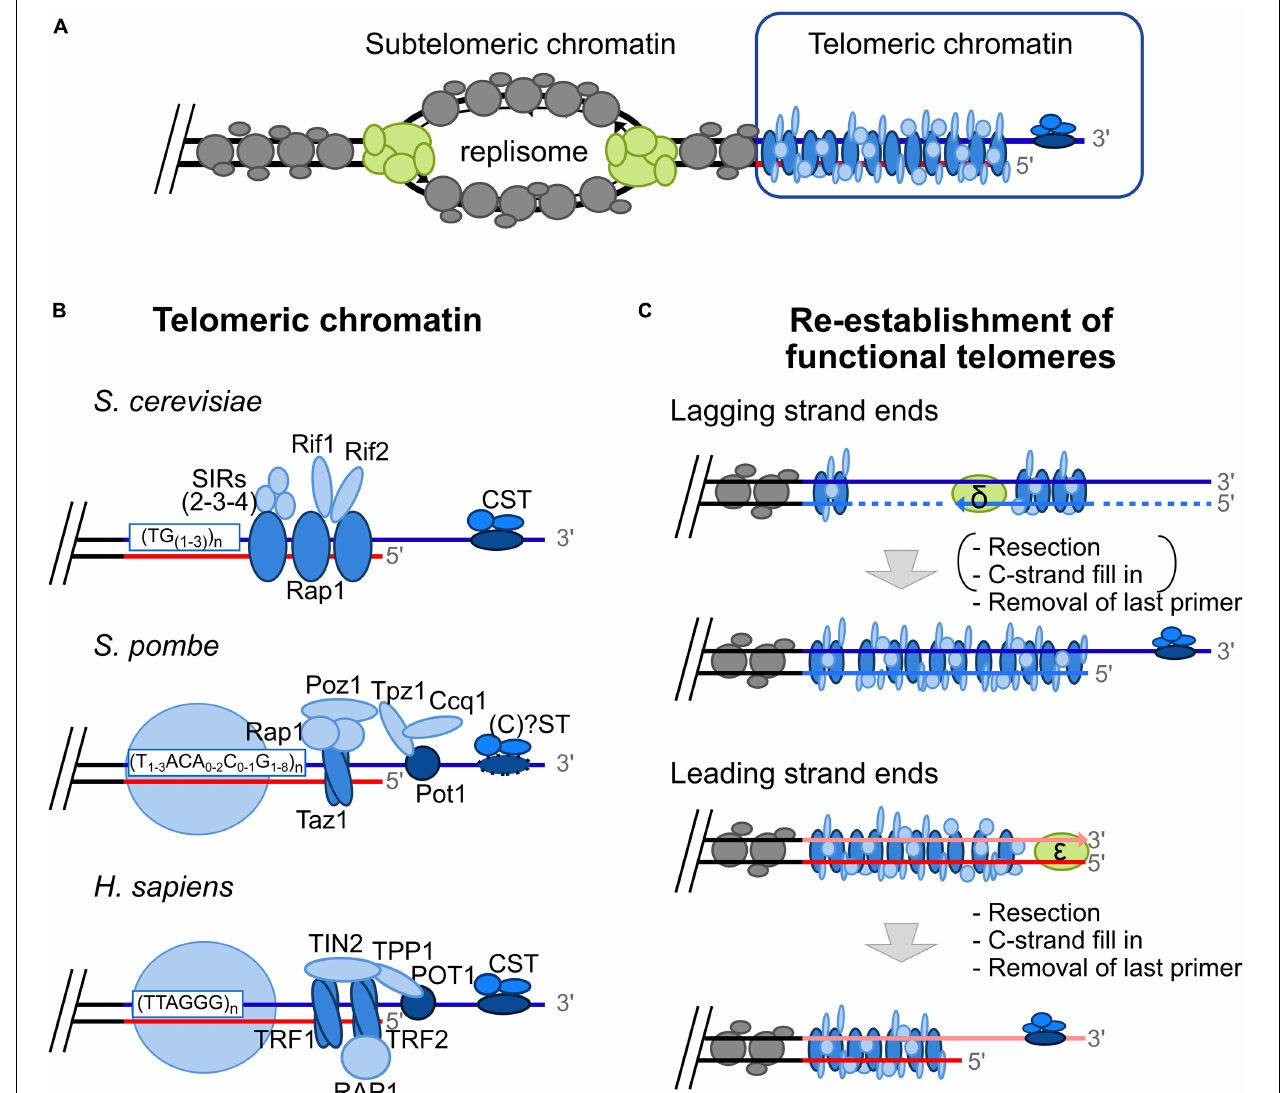
FIGURE 1 | The “Unusual” telomeric chromatin and the “classical” End Replication Problem. (A) Replication origins in subtelomeric areas fire in S-phase (humans) or in late S-phase (yeasts). At each fork, the replisome, a protein complex schematized here in green, allows DNA duplication. At the leading strand, DNA is synthesized by DNA polymerase ε in a continuous fashion, whereas at lagging strand, DNA synthesis by DNA polymerase δ occurs in a discontinuous fashion, i.e., in the form of Okazaki fragments. Subtelomeric chromatin is displayed in gray and the unusual telomeric chromatin is represented in blue. (B) Telomeric chromatin is unusual due to the binding of specific proteins in a sequence specific manner and lack of classical nucleosomes. Whereas telomeric chromatin in S. cerevisiae is devoid of nucleosomes (Wright et al., 1992), histones are present over telomeric repeats in S. pombe and humans in a non-canonical fashion (Greenwood et al., 2018). Rap1 recognizes dsDNA budding yeast telomeric repeats [(TG1-3) n] whereas Cdc13p binds the ssDNA telomeric overhang (Wellinger and Zakian, 2012). Telomere-bound Rap1 recruits several proteins such as the SIR complex (Sir2/Sir3/Sir4), and Rif1/Rif2. Cdc13 recruits Stn1 and Ten1, forming the CST complex. In S. pombe , Taz1 binds as homodimer on duplex telomeric DNA, whereas Pot1 recognizes single strand telomeric DNA. These two telomere-bound proteins recruit several proteins: Rap1, Poz1, Tpz1, and Ccq1 (Shelterin-like complex) (Moser and Nakamura, 2009). Whereas the homolog of Cdc13 has not been identified in this model organism, Stn1, and Ten1 are known to bind to telomeric ssDNA without forming a complex with the other ssDNA-binding protein Pot1 (Martín et al., 2007). Contrary to the heterogeneous telomeric repeats found in S. cerevisiae and S. pombe , TTAGGG repeats are found in most vertebrate species, including humans. The Shelterin complex is associated with human telomeric DNA and is comprised of TRF1 and TRF2 bound as homodimers on duplex DNA, POT1 on ssDNA, and associated proteins: RAP1, TIN2 and TPP1 (De Lange, 2005). (C) The “classical” End Replication Problem leading to progressive telomere shortening is the consequence of the unusual DNA structure of telomeres, i.e., the constitutive 3 (cid:48) overhang, that has to be reformed after conventional replication, and the unidirectionality of DNA synthesis by conventional replicative DNA polymerase (from 5 (cid:48) to 3 (cid:48) ). Indeed, the G-rich strand (blue line) is used as DNA template by lagging strand machinery (primase-DNA polymerase α , synthesizing a RNA-DNA primer (dotted line) followed by extension by DNA polymerase δ ). Removal of the last primer is expected to be sufficient to reform functional telomeres, at least in yeast. The leading strand machinery (DNA polymerase ε ) allows complementary synthesis of the C-rich strand leading to a blunt end. 5 (cid:48) resection followed by C-strand fill in and removal of the last primer allows re-establishment of functional telomeres. It should be noted that resection and C-strand fill in occur at lagging strand ends in humans [mentioned under parentheses in the scheme; (Wu et al., 2012)].